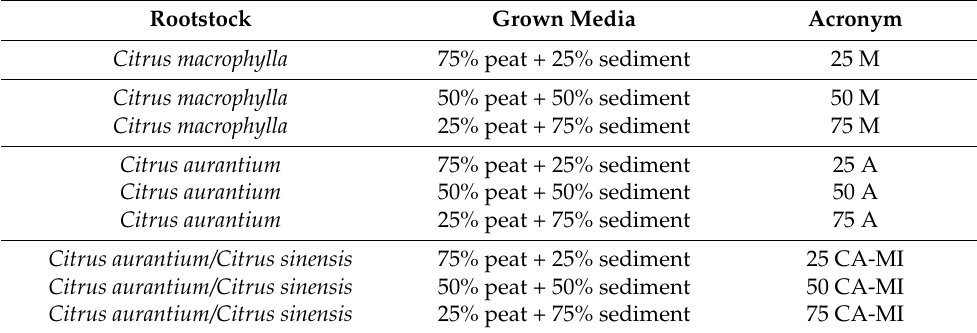
Table 1. Specifications of the rootstock and the crop media of the Citrus limon ‘Verna’ var. lemons evaluated in this study, with emphasis on the acronym